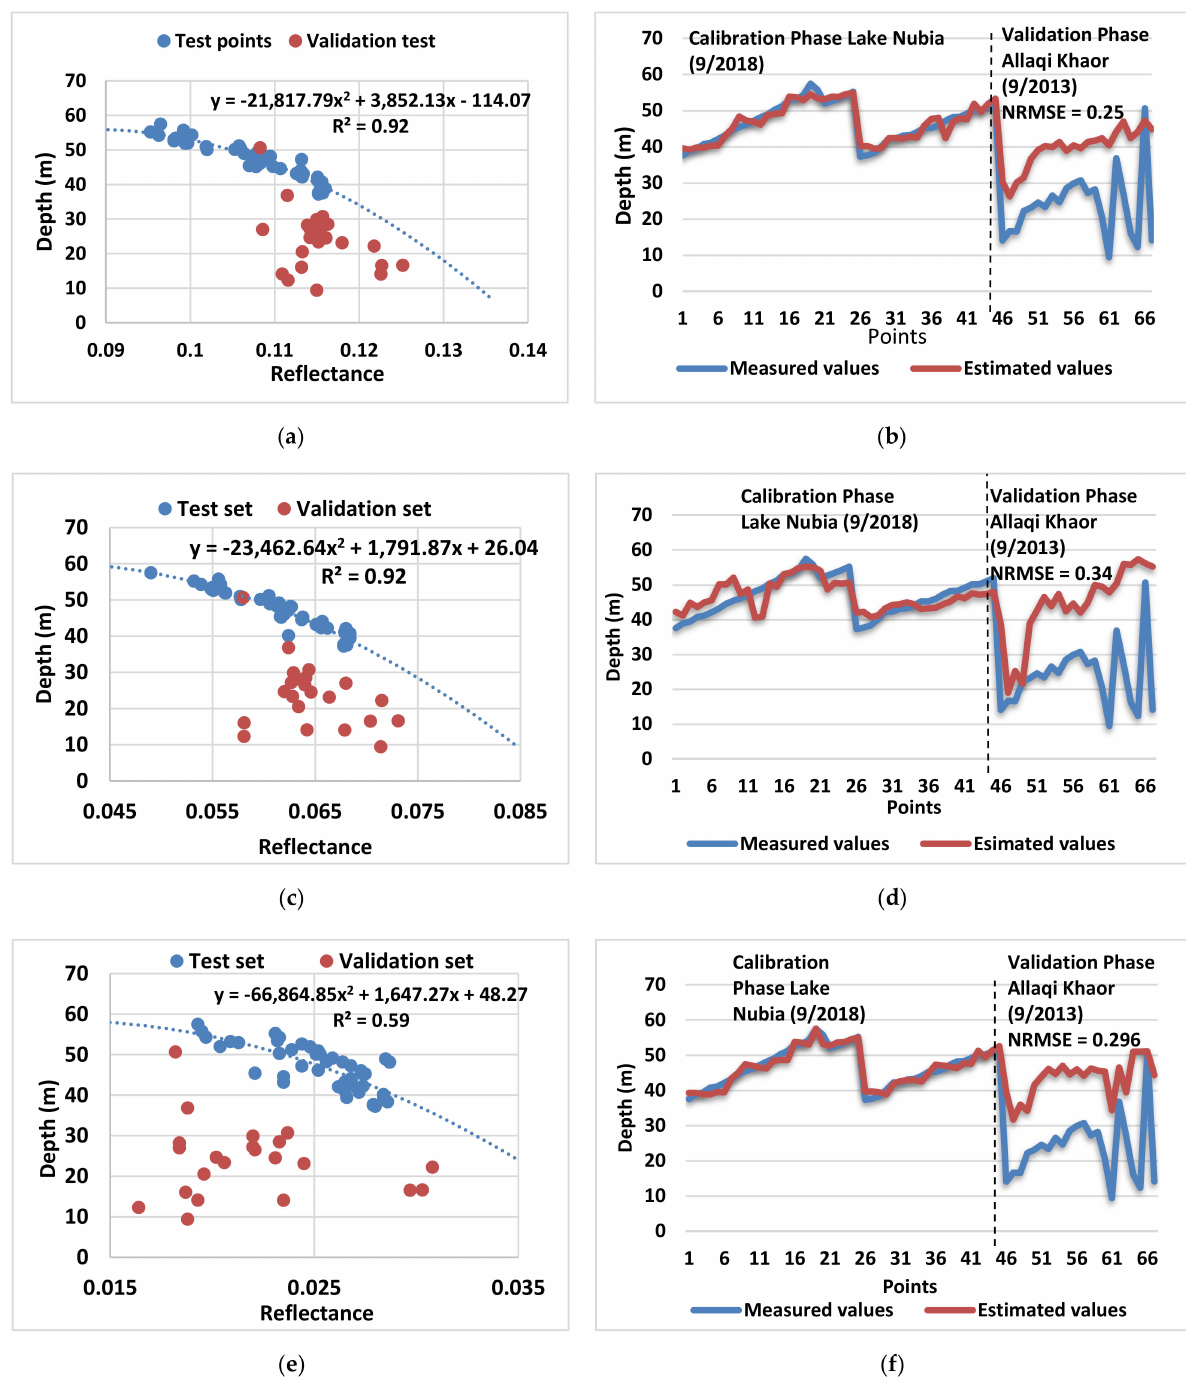
Figure 10. Regression model of OLCI reflectance and depth; ( a ) In situ measured depth and reflectance of Qa6 (Green band) relationship, and result of correlation and polynomial equation ( b ) Model results’ validation of Qa6 (Green band), NRMSE between estimated and in situ measured depth ( c ) In situ measured depth and reflectance of Qa8 (Red band) relationship, and result of correlation and polynomial equation ( d ) Model results validation of Qa8 (Red band), NRMSE between estimated and in situ measured depth ( e ) In situ measured depth and reflectance of Qa17 (NIR band) relationship, and result of correlation and polynomial equation ( f ) Model results’ validation of Qa17 (NIR band), NRMSE between estimated and in situ measured